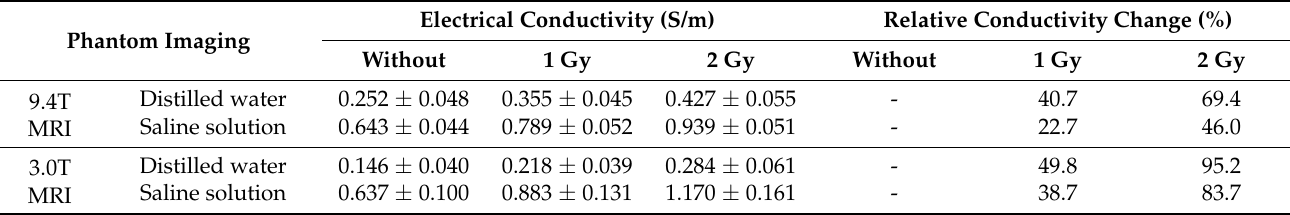
in the distilled water was higher than that of the saline solution.